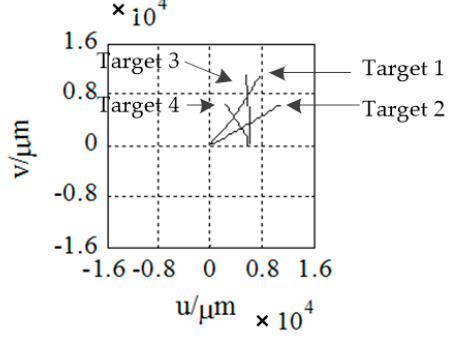
Figure 9. Traces of the targets on the focal plane.